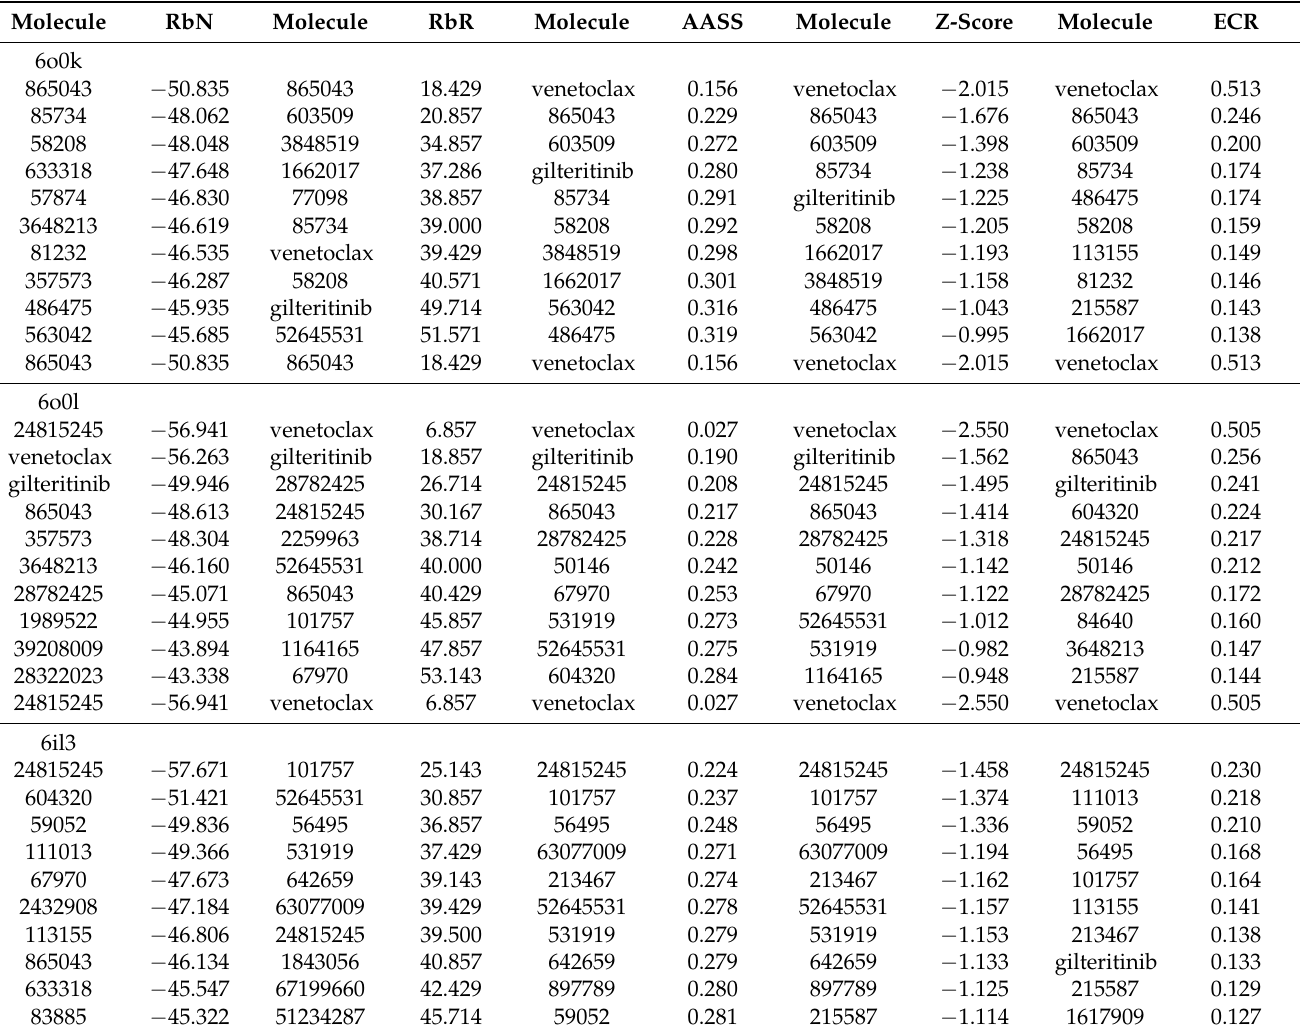
Table 2. The top 10 hit molecules from the five consensus ranking methods that were used to combine the seven docking scores. The molecules from the traditional herbs are named according to the CAS number that was used to extract them from the NIST database. The names of all of the molecules are added to Table S1 of the Supplementary